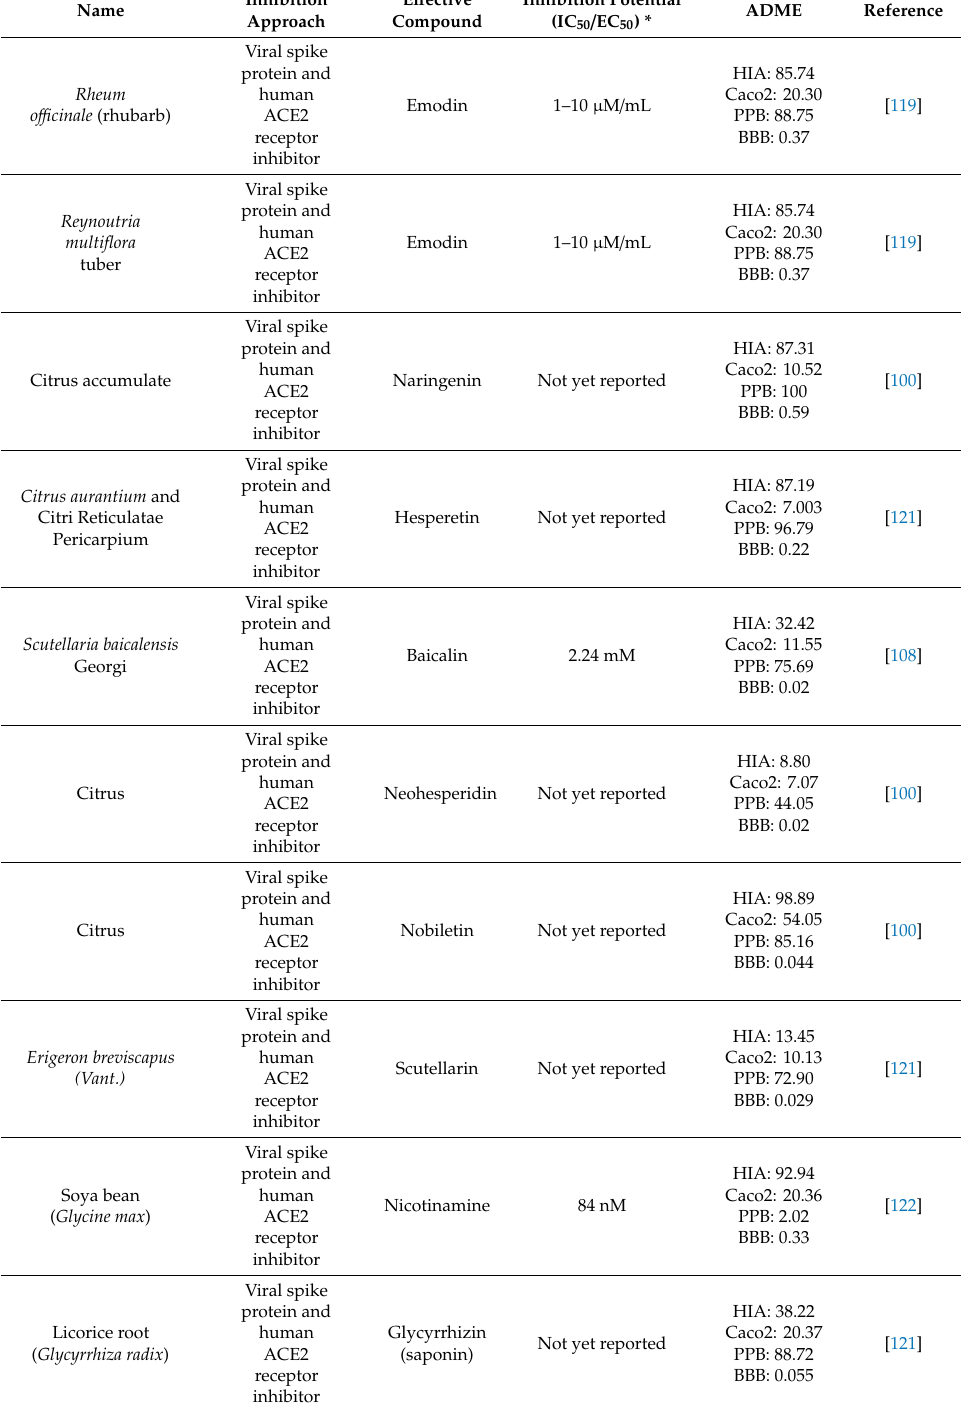
Table 2. Plants with potential ACE2 receptor inhibition